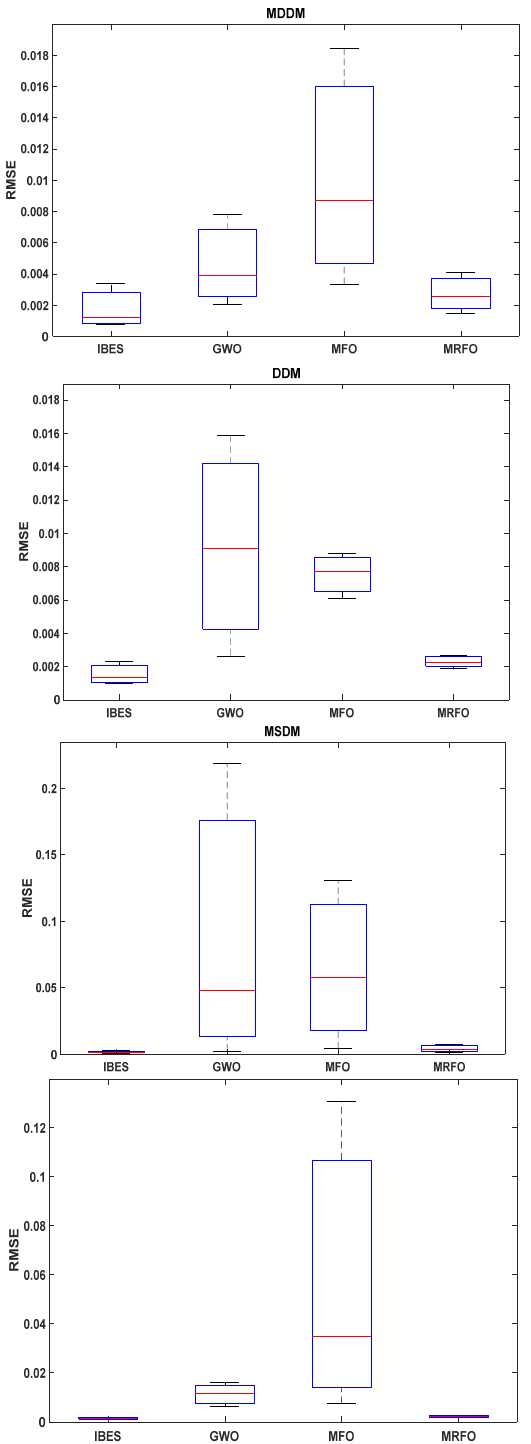
Figure 22. Boxplots of the IBES, GWO, MFO, and MRFO applied to the MDDM, DDM, MSDM and